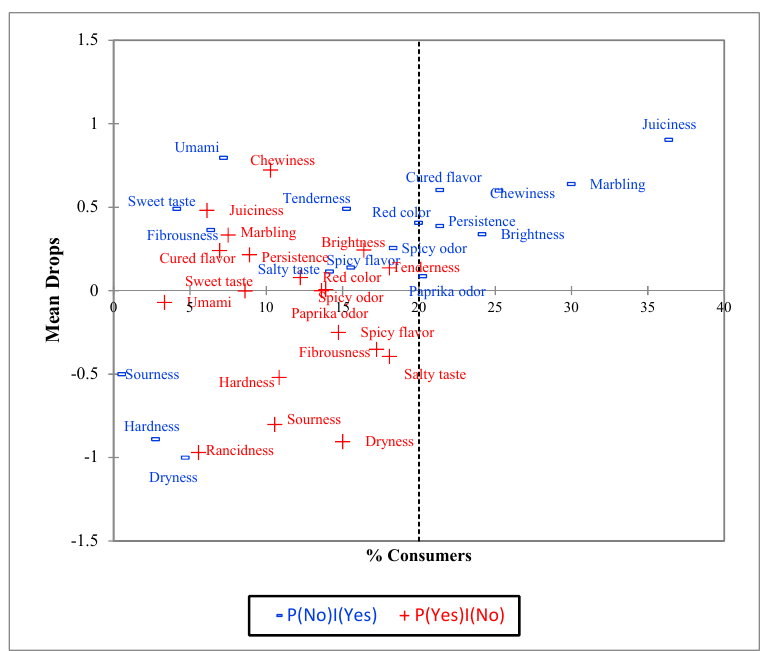
Figure 3. Penalty Analysis (PA) from CATA with ideal data, in which the attribute is selected for the ideal product, but missing in the real products (‘must have attributes) (blue terms), and in which the attribute is not selected for the ideal, but endorsed for the real products (‘nice to have’, ‘must not have’, ‘does not harm’ attributes) (red terms).